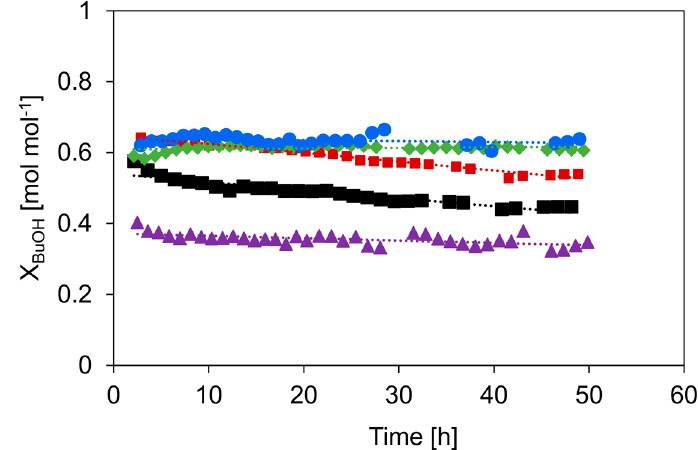
Figure 6. Site time yield (STY) as a function of the ratio of the amount of strong acid sites over medium Figure 8. X BuOH as a function of time on stream: c-HZSM-5 ( (cid:4) , black), n-HZSM-5 ( (cid:4) , red), PM-50 / 50 Figure 8. X BuOH as a function of time on stream: c-HZSM-5 (  , black), n-HZSM-5 (  , red), PM-50/50 acid sites. Symbols: c-HZSM-5 (  , black), n-HZSM-5 (  , red), PM-50/50 (  , purple), Hybrid-50/50 (  , ( (cid:78) , purple), Hybrid-50 / 50 ( (  , purple), Hybrid-50/50 (  , green), and γ -Al 2 O 3 (  , blue). Temperature = 513 K, inlet pressure of K, inlet pressure of n-butanol = 29 kPa, total pressure green), and γ -Al 2 O 3 (  , blue). Temperature = 513 n-butanol = 29 kPa, total pressure = 5 bar. = 5